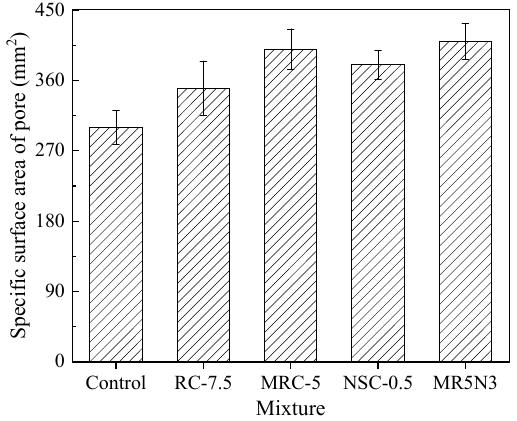
Materials 2021 , 14 , x FOR PEER REVIEW